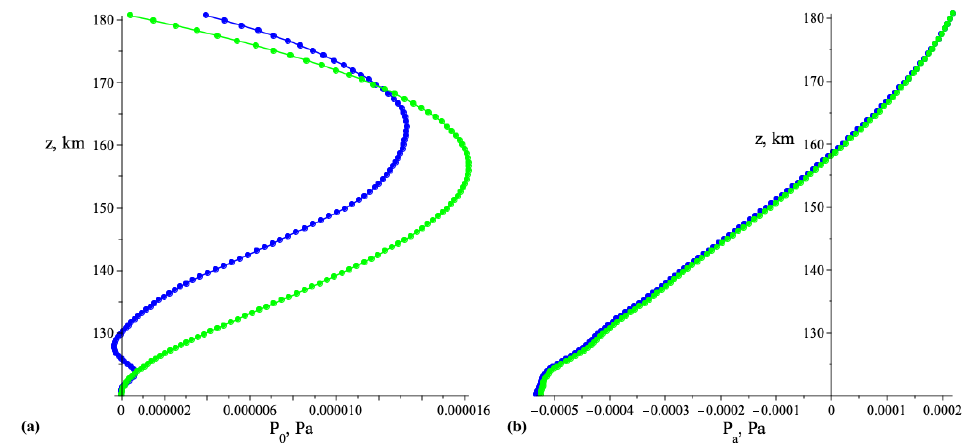
Figure 4. Comparison of the entropy mode P 0 ( z ) ( a ) and the acoustic one P a ( z ) ( b ) obtained using the formulas (A2) and (A8), respectively, for the cases of standard atmosphere H ( z ) (25) (in blue) and linear height scale dependence H ( z ) model (27) (in